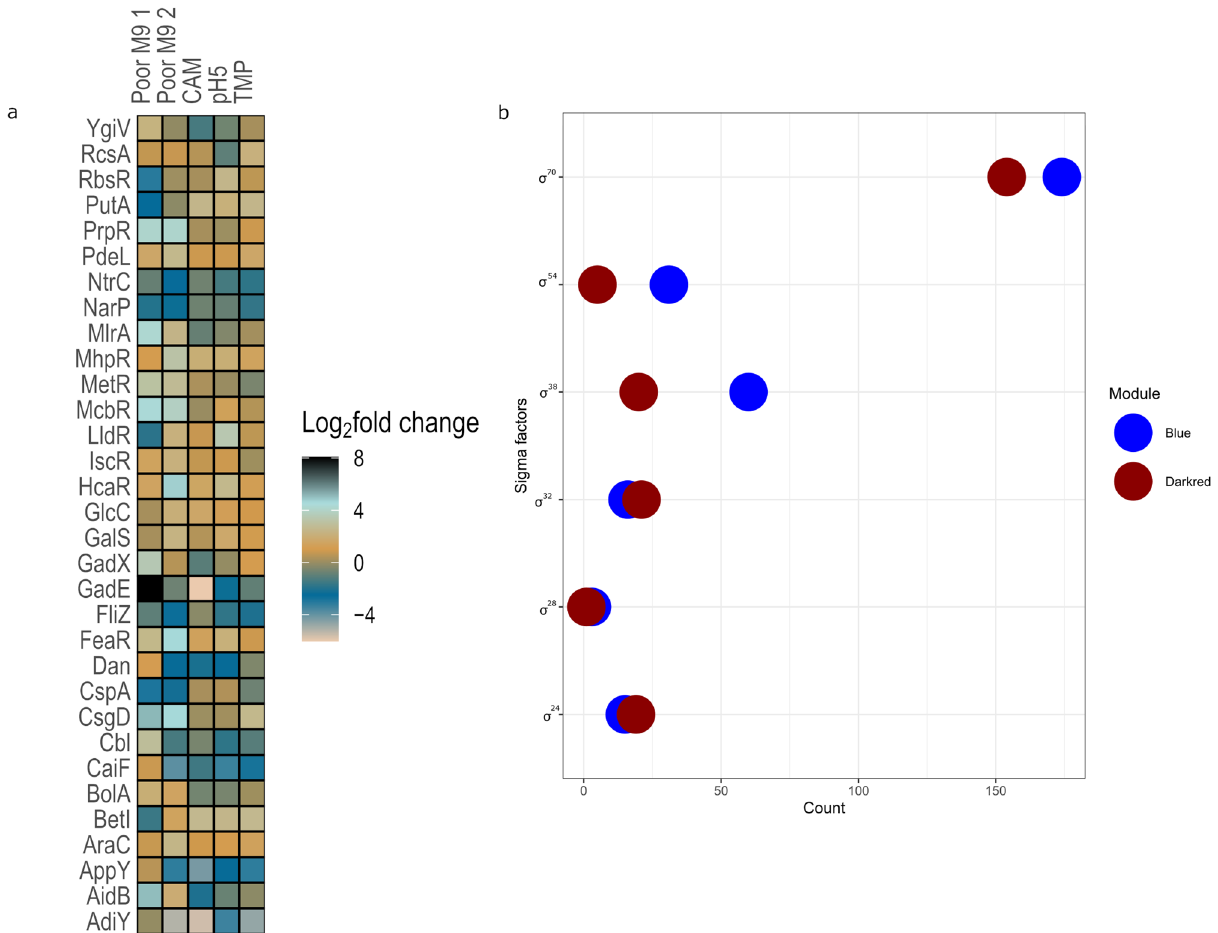
Figure 6. Distribution of transcription factors (TFs) and sigma factors. ( a ) Heatmap showing the log 2 fold change value of the 32 differentially expressed TFs (from left to right) in Poor M9 1 compared with LB, Poor M9 2, CAM, pH5 and TMP compared with Rich M9. ( b ) Dot plot showing the distribution of sigma factors in blue and darkred